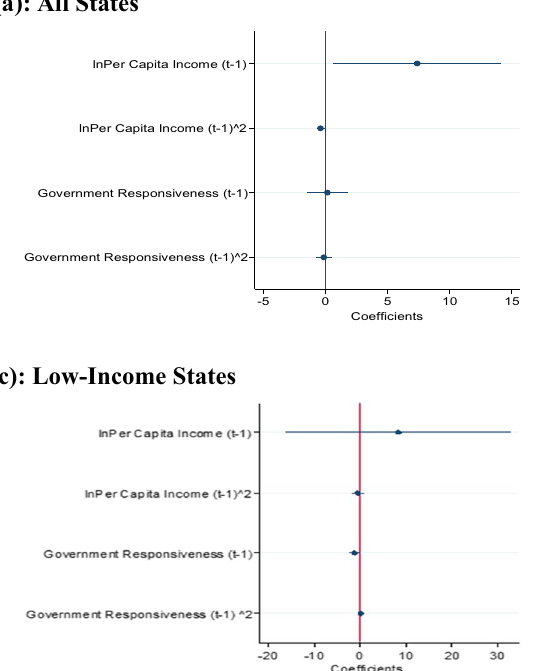
Figure 1. Coefficient plot—flood fatalities and income and Government responsiveness.